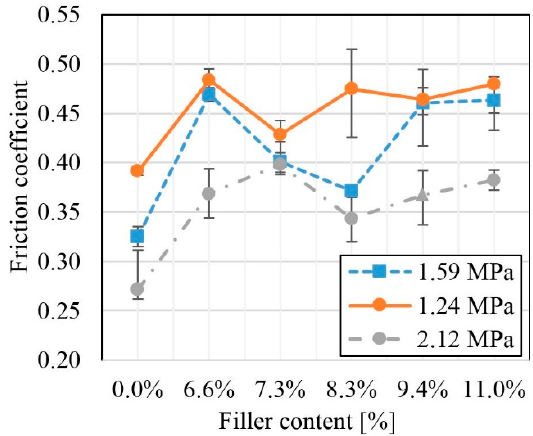
Figure 10. The kinetic friction coefficient depending on the unit pressures.